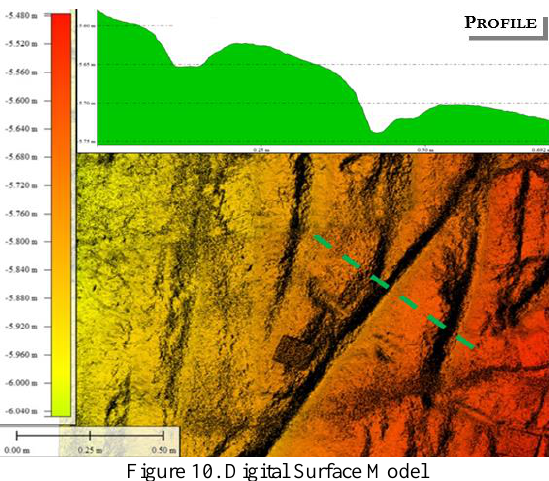
Figure 10. Digital Surface Model